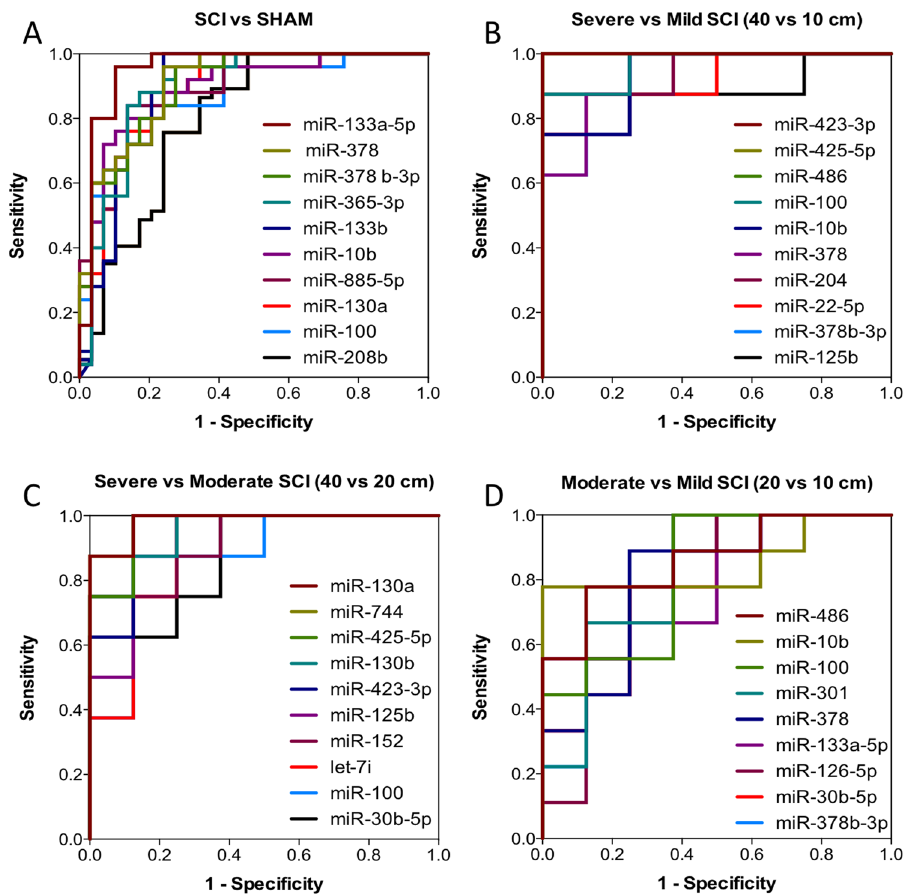
miR-10b (AUC = 0.94), miR-378 (AUC = 0.94), miR-204 (AUC = 0.92), miR-22-5p (AUC = 0.92), miR- 378b-3p (AUC = 0.92), and miR-125b (AUC = 0.91) ( C ). Severe and Moderate SCI (40 vs 20 cm), the AUC’s were miR-130a (AUC = 0.98), miR-744 (AUC = 0.98), miR-425-5p (AUC = 0.97), miR-130b (AUC = 0.95), miR-423-3p (AUC = 0.95), miR-125b (AUC = 0.92), miR-152 (AUC = 0.92), let-7i (AUC = 0.89,), miR-100 (AUC = 0.88), and miR-30b-5p (AUC = 0.88) ( D ). Moderate and Mild SCI (20 vs 10 cm), the AUC’s were miR-486 (AUC = 0.86,), miR-10b (AUC = 0.85), miR-100 (AUC = 0.82), miR-301 (AUC = 0.82), miR-378 (AUC = 0.81), miR-133a-5p (AUC = 0.79), miR-126-5p (AUC = 0.79), miR-30b-5p (AUC = 0.79), and miR- 378b-3p (AUC =